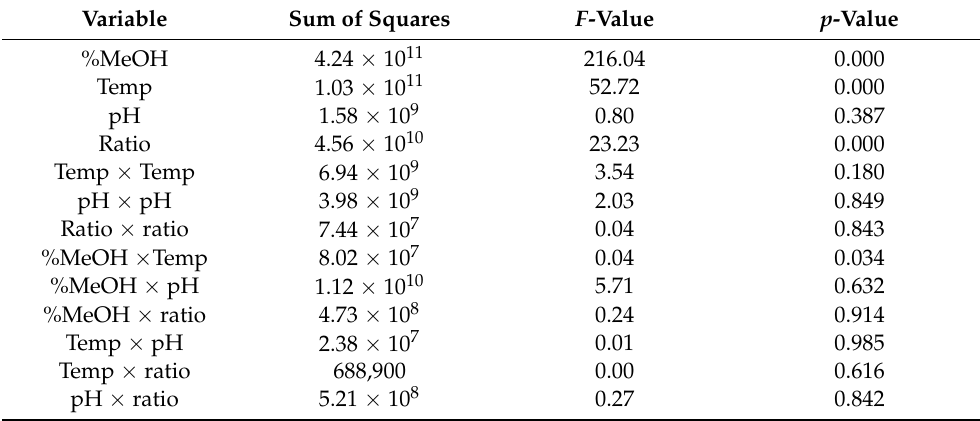
Table 2. BBD-RSM analysis of the total anthocyanins recovery from Erica australis flowers. Variable Sum of Squares F -Value p -Value